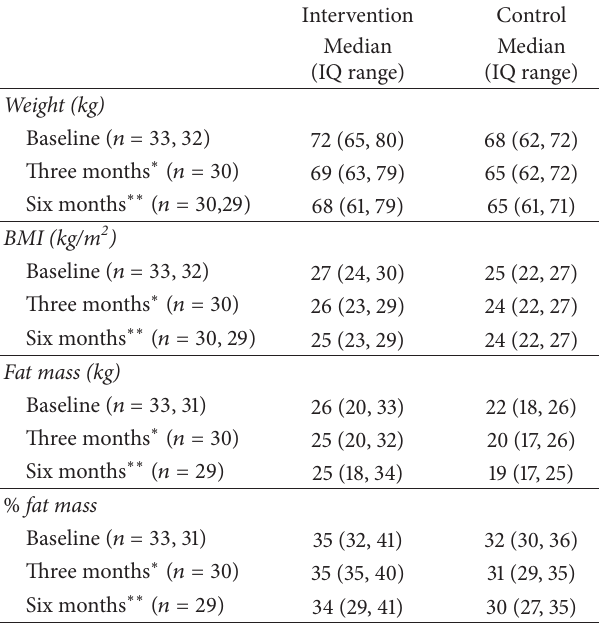
Table 2: Weight and body composition results at baseline and three and six months of follow-up in response to a 10-week physical activity intervention.